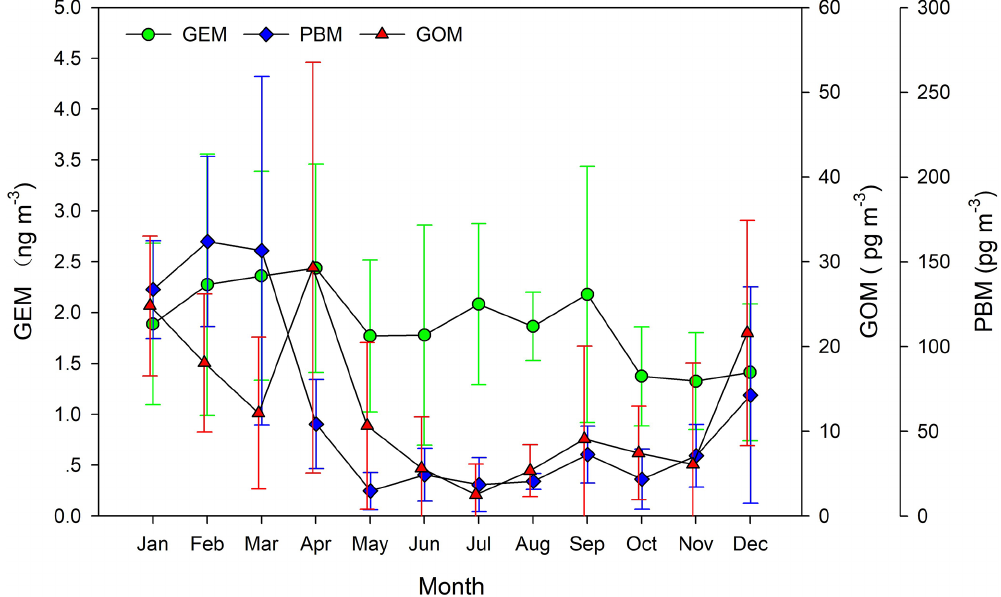
Figure 3. Monthly means of GEM, GOM and PBM at WLG during a full-year sampling period. Error bars indicate the 1 SD of monthly mean